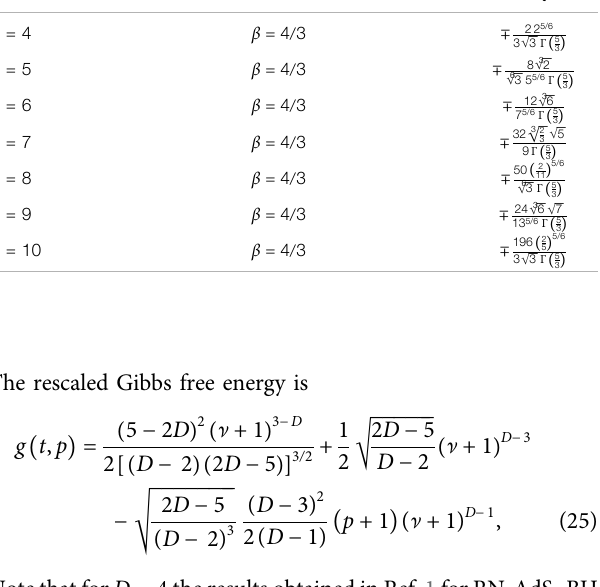
TABLE 1 | Limits and fractional order phase transition at the critical point for D dimensional RN-AdS BH. Dimension